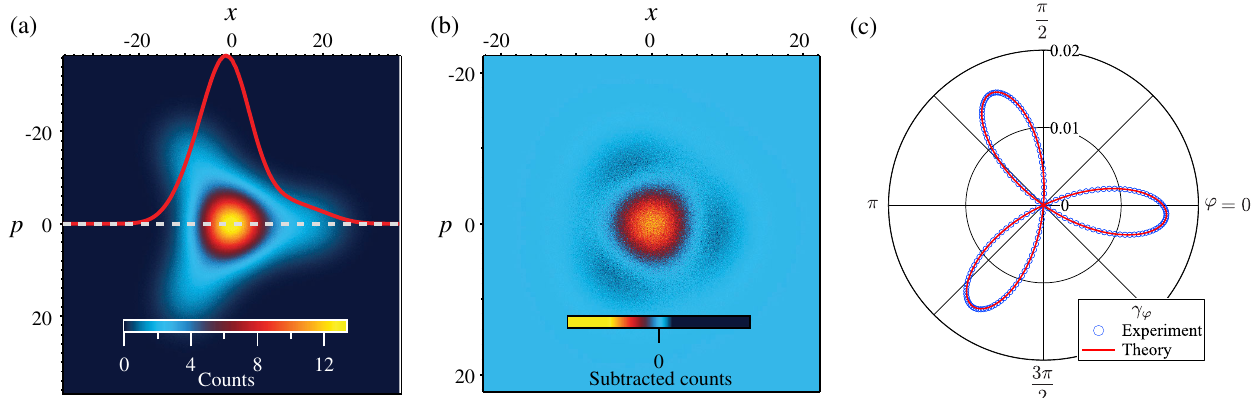
FIG. 2. Measured histograms of trisqueezed states in a single mode. (a) A histogram of a bright trisqueezed state with F ≈ 66 . The triangular symmetry of the histogram is apparent, clearly indicating its non-Gaussian character. The inset shows the projection of the 2D histogram onto the x quadrature, which displays a significant amount of asymmetry (skewness), despite the system noise. (b) A histogram of a trisqueezed state with F ≈ 1 after subtracting the system noise histogram. The triangular symmetry is still apparent despite the low photon flux. (c) A polar plot of the skewness γ φ of the generalized quadrature x φ (see the text) as a function of the phase angle φ , showing data and theory. The small rotation of γ φ is caused by a relative phase between the microwave pump and the local oscillator of the heterodyne receiver. The theory curve is normalized to the maximum experimental value and rotated appropriately but otherwise has no adjustable parameters. The plot is produced from the same raw data as (b) but without subtracting the system noise. This statistic essentially measures the asymmetry of the quadrature distribution with respect to the symmetry axis perpendicular to x φ . We see that the triangular symmetry of the underlying state is very visible even though it is completely obscured in a histogram of the raw data, which suggests that γ φ is a good way to analyze the non-Gaussian character of our trisqueezed states. This approach is particularly effective because the skewness of the Gaussian system noise is zero (within our measurement